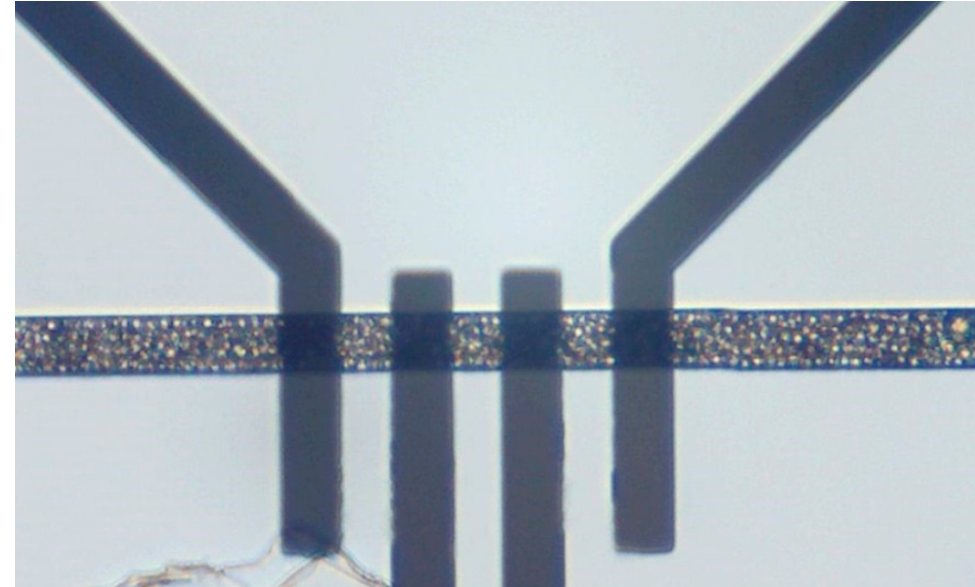
Figure A5. Examples of the yeast cap obtained in the measurement area via the injection of a sample with high cell concentration for sensor S4 (magnification 100×).